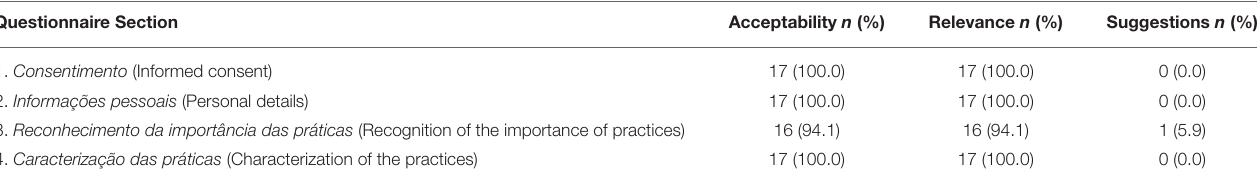
TABLE 1 | The number of positive responses among the participants ( n = 17) concerning the acceptability, relevance, and suggestions of questionnaire sections during the ecological validation process. Questionnaire